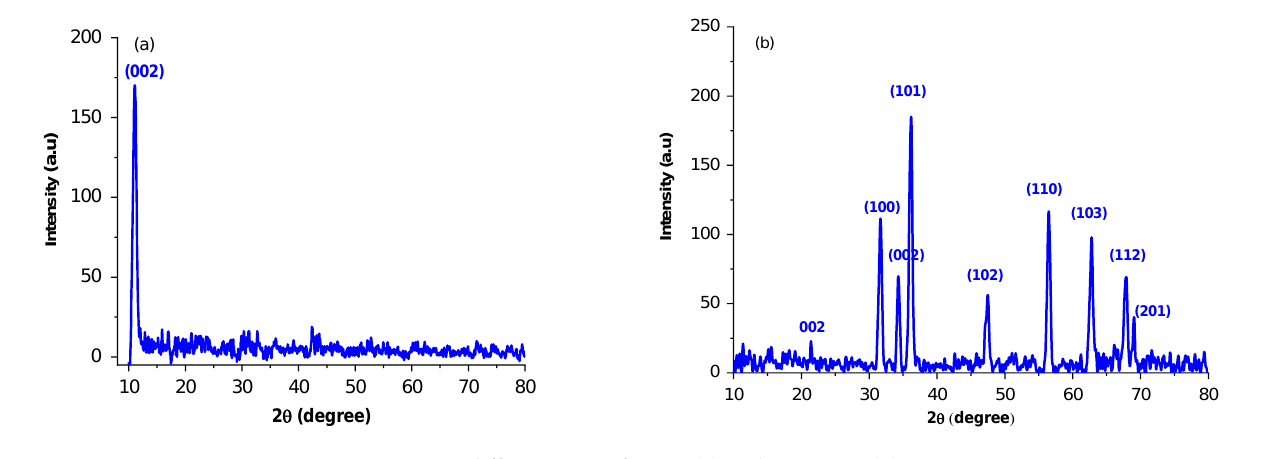
Figure 1. X-rays diffractograms for GO ( a ) and rGO-ZnO ( b ).